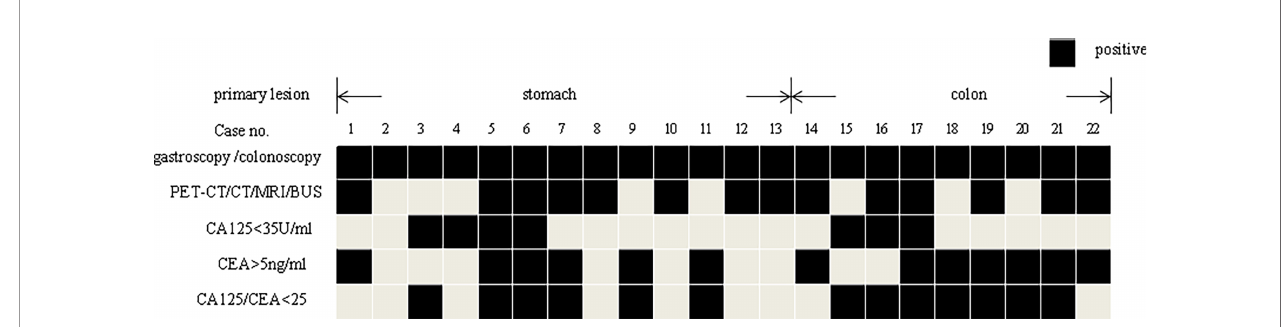
FIGURE 3 | The gastroscopy/colonoscopy, imaging, and tumor marker results of the patients ’ metastasis from stomach or colon.